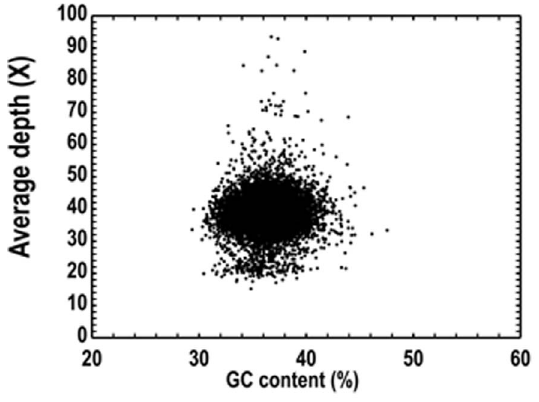
Figure 2. Distribution between GC content and sequencing